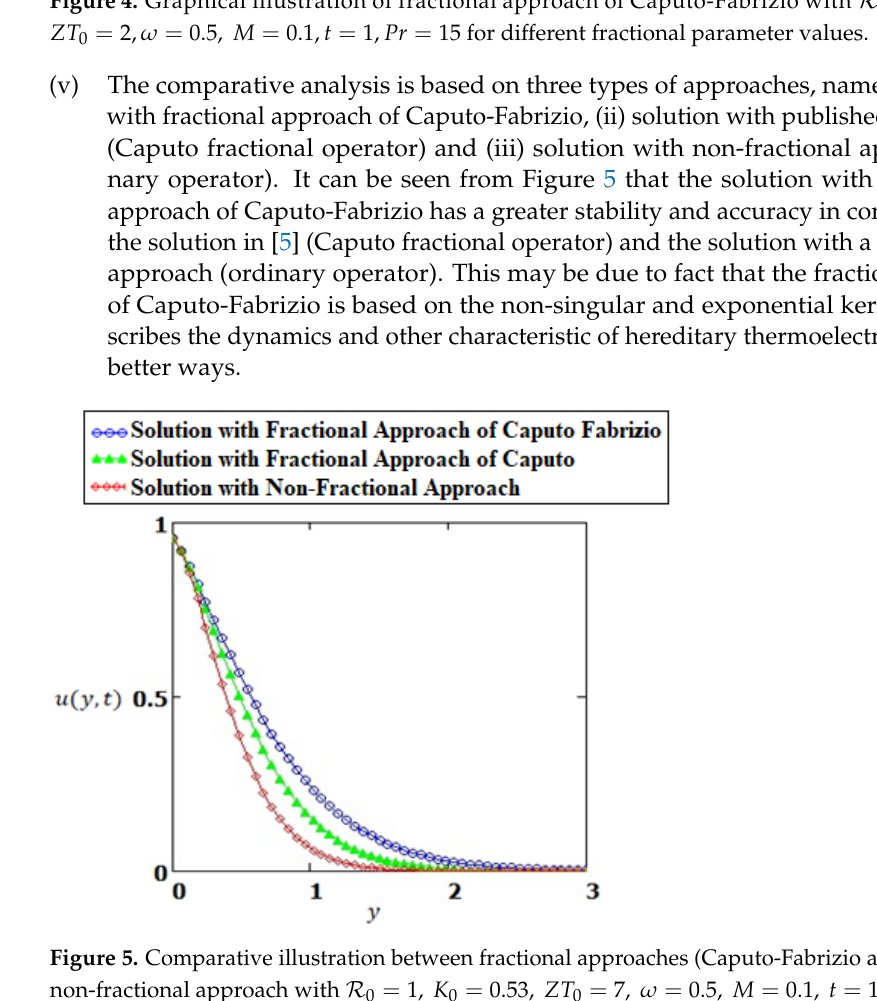
Figure 4. Graphical illustration of fractional approach of Caputo-Fabrizio with R 0 = 1, K 0 = 0.9, ZT 0 = 2, ω = 0.5, M = 0.1, t = 1, Pr = 15 for different fractional parameter values. (v)